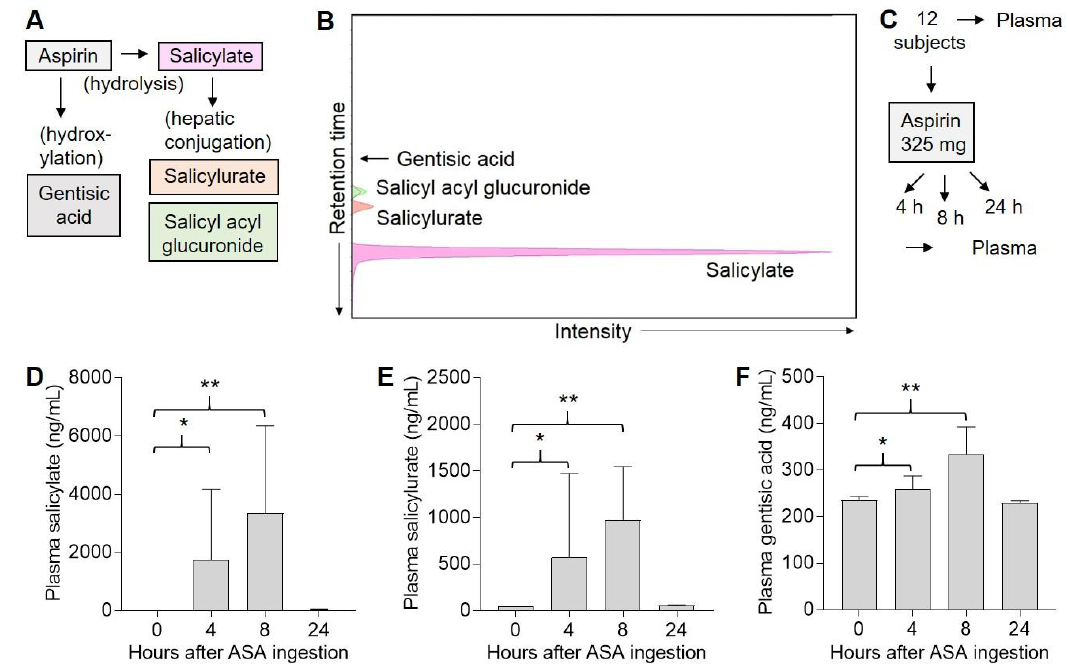
Figure 2. Detection of ASA metabolites in human plasma. ( A ), Metabolism of ASA. ( B ), Liquid chromatography–mass spectrometry (LC–MS) detection of ASA metabolite standards. ( C ), Experimental design. Human subjects were each given a single 325 mg dose of ASA, and blood was drawn both before (0 h) and either 4 (n = 5), 8 (n = 3), or 24 (n = 3) h later. Plasma was isolated from blood, and 0.5 mL was extracted for LC–MS analysis. ( D ), Plasma salicylate levels. Error bars indicate SEM. * p = 0.02, ** p = 0.001. ( E ), Plasma salicylurate levels. Error bars indicate SEM. * p = 0.07, ** p < 0.001. ( F ), Plasma gentisic acid levels. Error bars indicate SEM. * p = 0.03, ** p < 0.001. Note: ASA and salicyl acyl glucuronide were not detected in any of the samples.